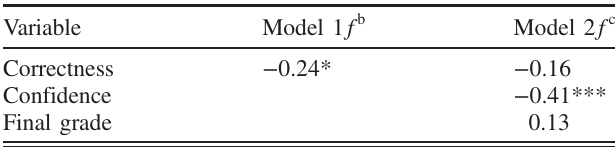
TABLE III. Fitted linear regression models explaining variation in confusion index by selected variables of student learning and engagement, fall 2010 ( N ¼ 106 ). a